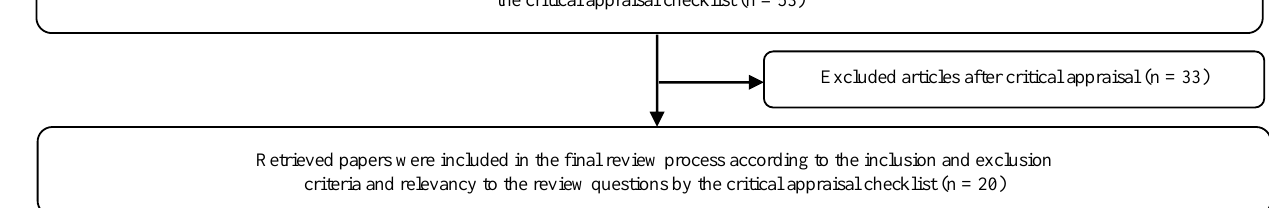
Figure 1. Flow diagram of articles